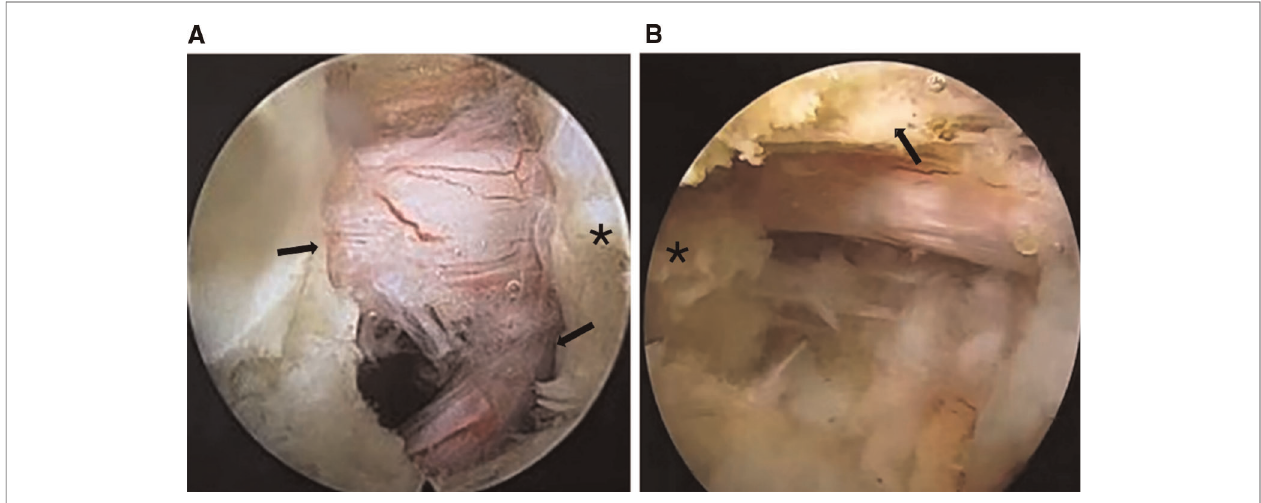
FIGURE 1 | The intraoperative decompressed dural sac and nerve-root. ( A ) F-PELD via the posterior interlaminar approach in L5-S1, variant nerve root(see arrows), cranial side(see star). ( B ) F-PELD via the lateral transforaminal approach in L4-5 showed in the right picture, ventral side of the superior articular process (see arrows), cranial side(see star).